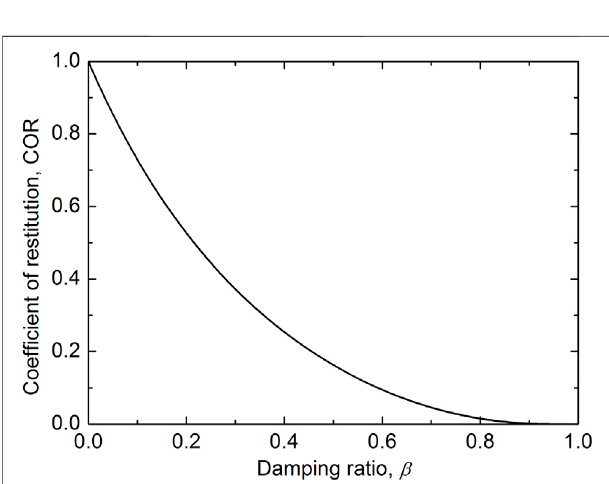
FIGURE 12 | Relationship between the coef fi cient of restitution (COR) and the damping ratio ( β ).